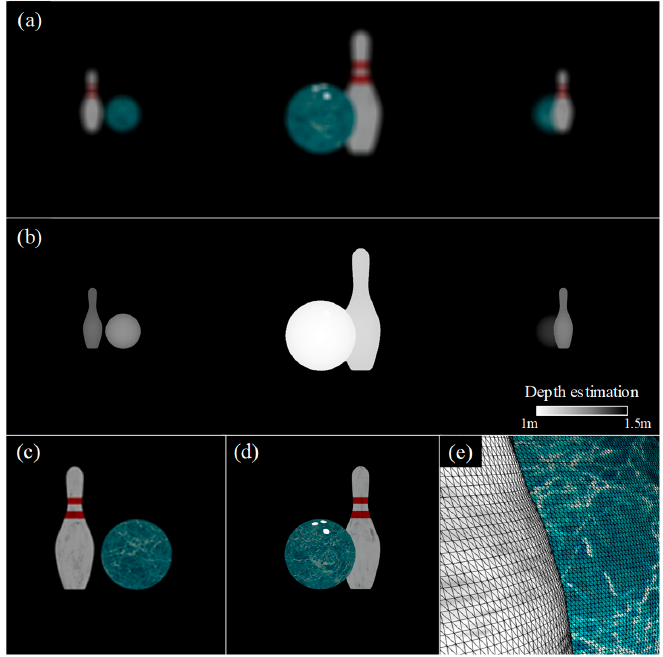
Figure 7. ( a ) Simulated light field image in the proposed optical setup; ( b ) extracted depth information of the light field; ( c ) refocused image of left perspective of the light field; ( d ) refocused image of the center perspective; and, ( e ) reconstructed three-dimensional (3D) triangular mesh from the color point